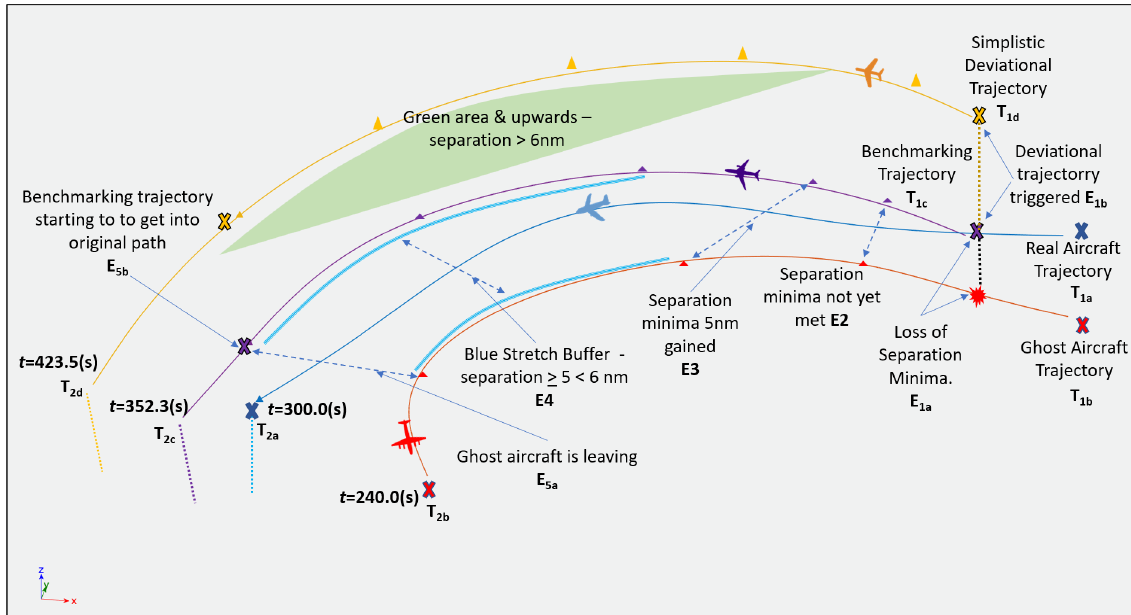
Figure 5. Simulation results—performance of tactical manoeuvring against conventional simplistic